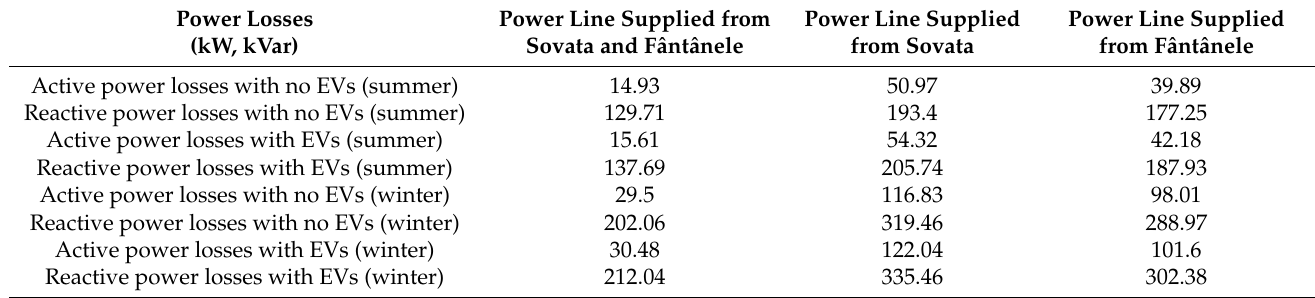
Table 29. Power losses at 19:00 (scenario 6).